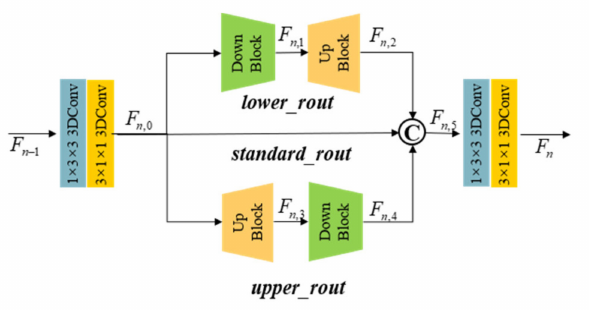
Figure 2. Architecture of the MSFMB. © represents the concatenation